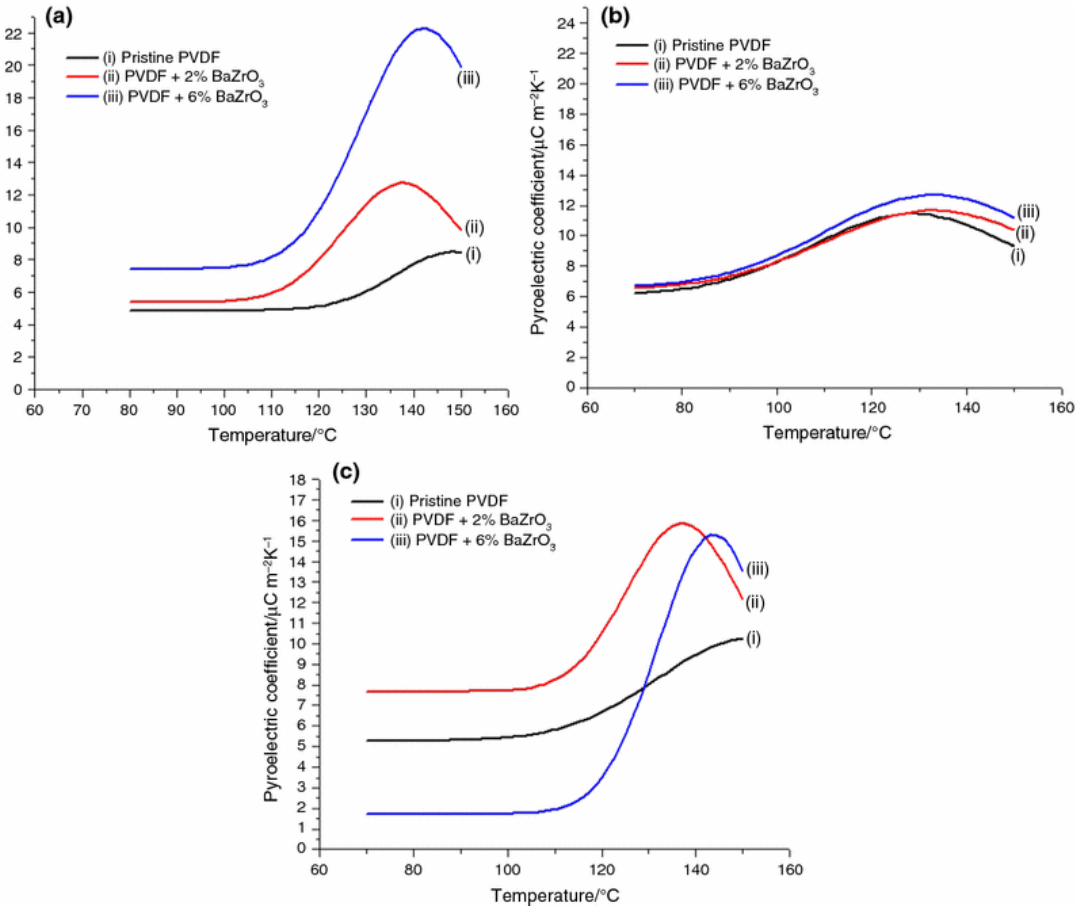
Figure 9. Pyroelectric coefficient of PVDF and PVDF nanocomposites depended on temperature of ( a ) 1 °C/min, ( b ) 2 °C/min, and ( c ) 3 °C/min heating rate [108].